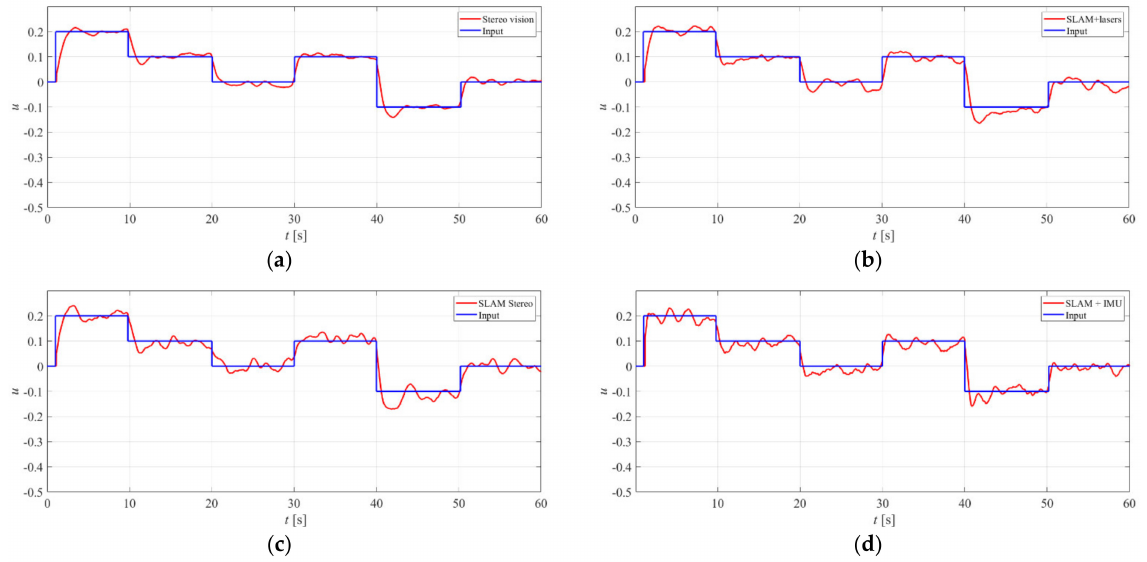
Figure 17. Surge control at variable speed: ( a ) stereo vision; ( b ) SLAM lasers; ( c ) SLAM stereo; ( d ) SLAM IMU.